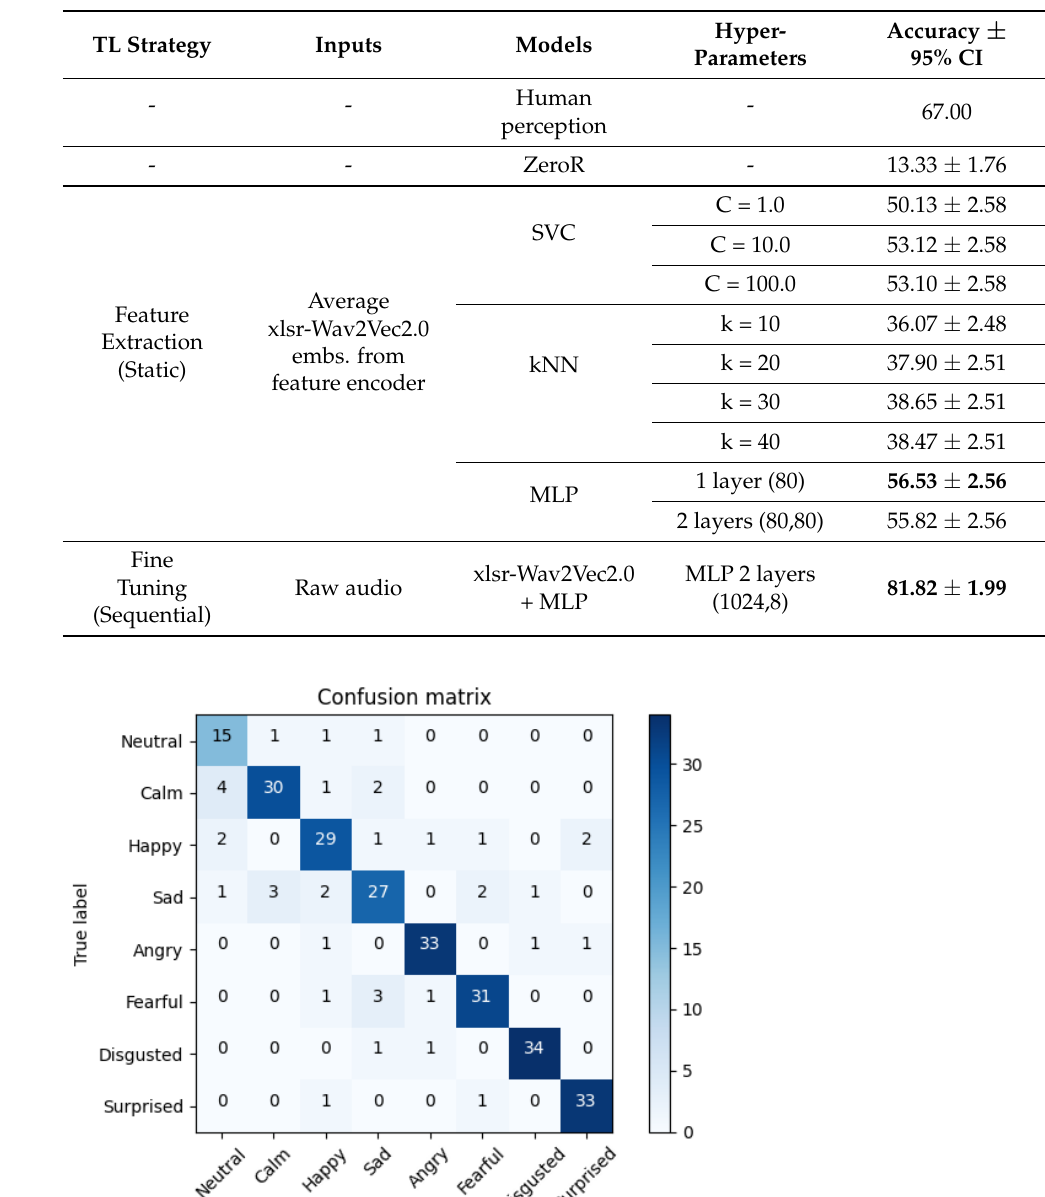
Table 1. Quantitative evaluation of the different strategies on speech emotion recognition. In bold, the best models per TL strategy.